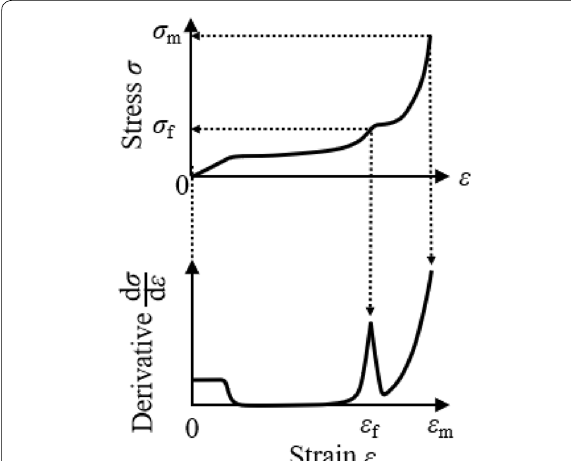
Fig. 3 Method for calculating the deformation parameters from the stress–strain curve